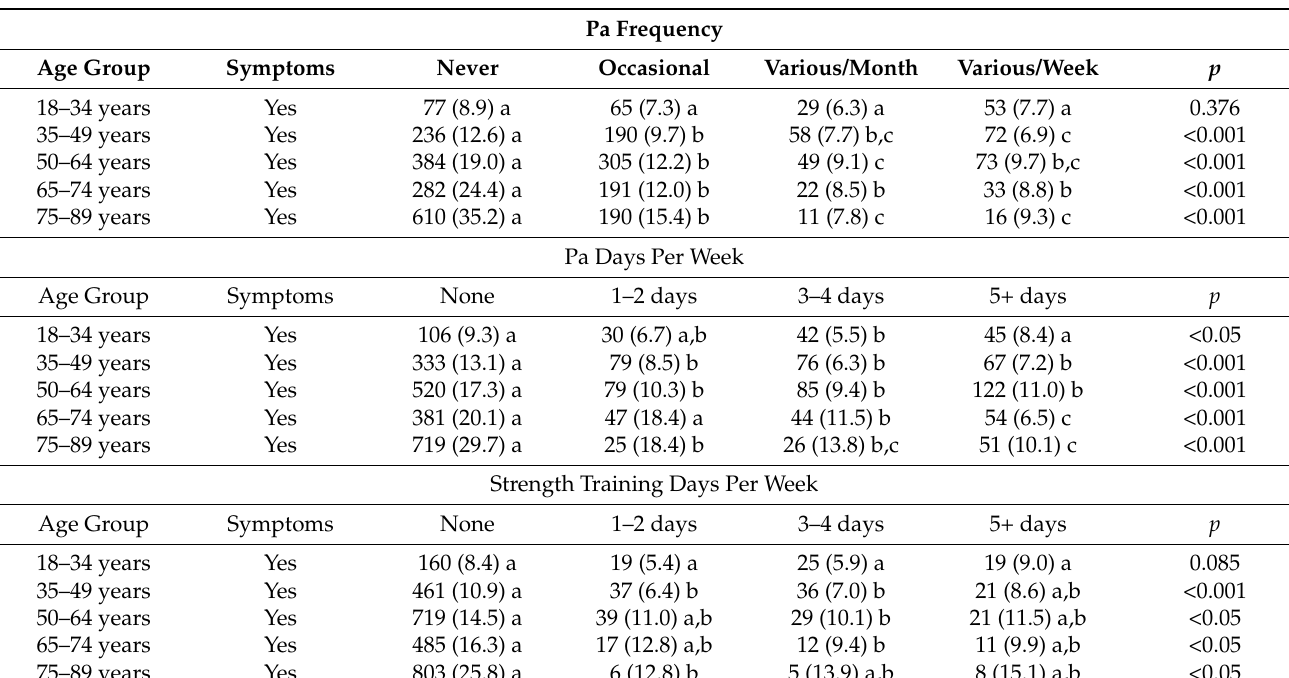
Table 4. Relationship between the frequency of PA. Days a week of PA and muscle strengthening and having any depressive symptoms, according to phq8 in the Spanish population by age group.